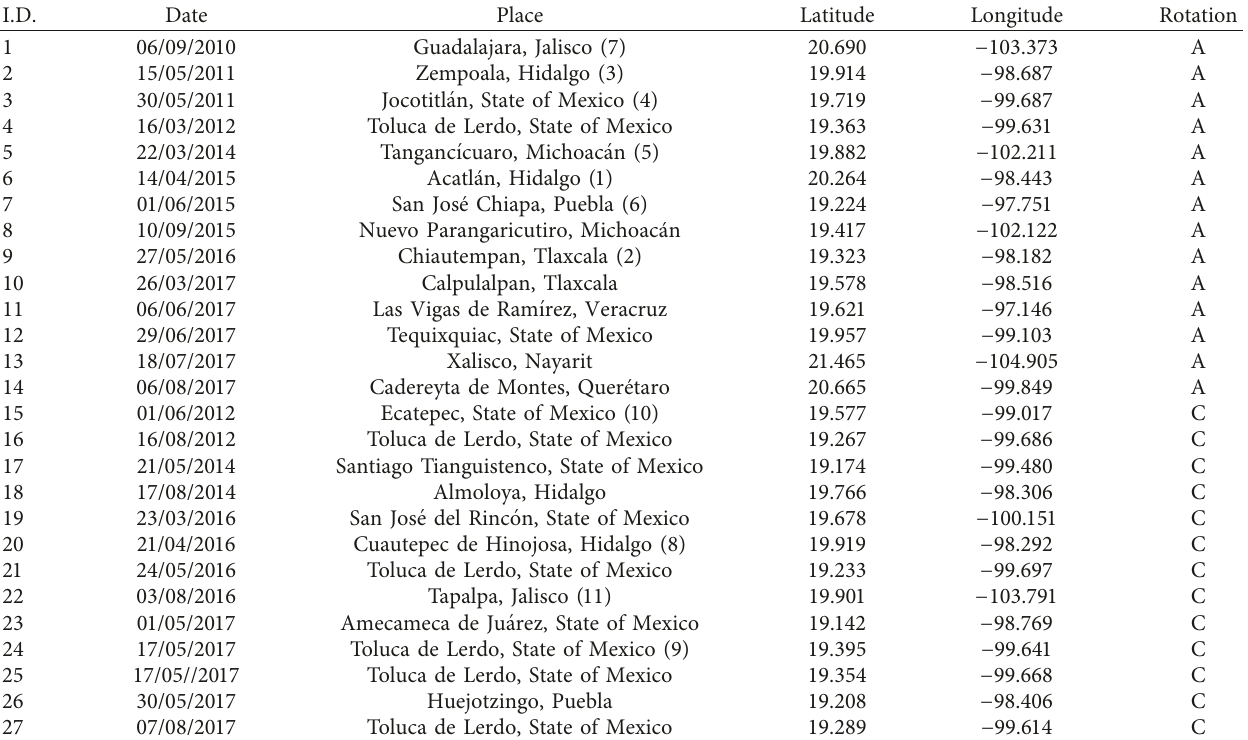
Table 1: Summary of tornado events in the Trans-Mexican Volcanic Belt (2010–2017) with video evidence on the sense of rotation (A: anticyclonic; C: cyclonic). I.D.